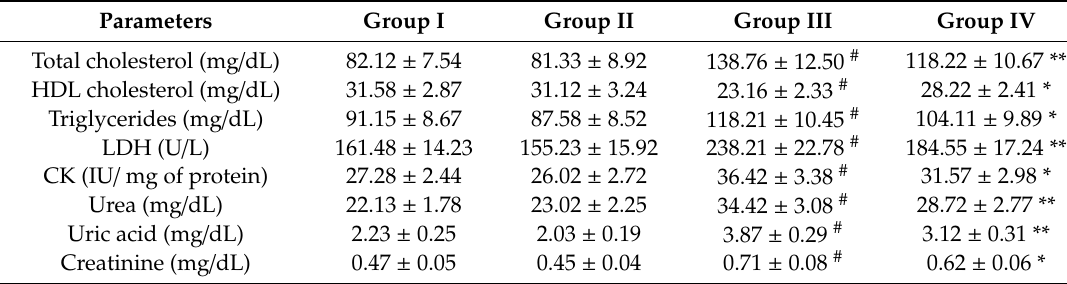
Table 1. The e ff ects on serum biochemical parameters in the absence (CdCl 2 ) and presence of RA (CdCl 2 + RA) in mice.